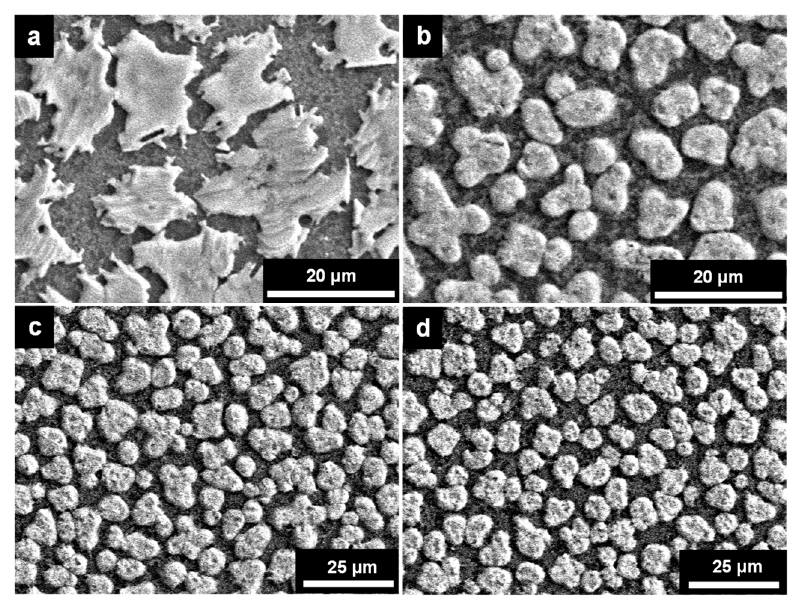
Figure 4. SEM images of the MAPbI 3 /(DPPS) perovskite solar cells. The concentration of DPPS are ( a )